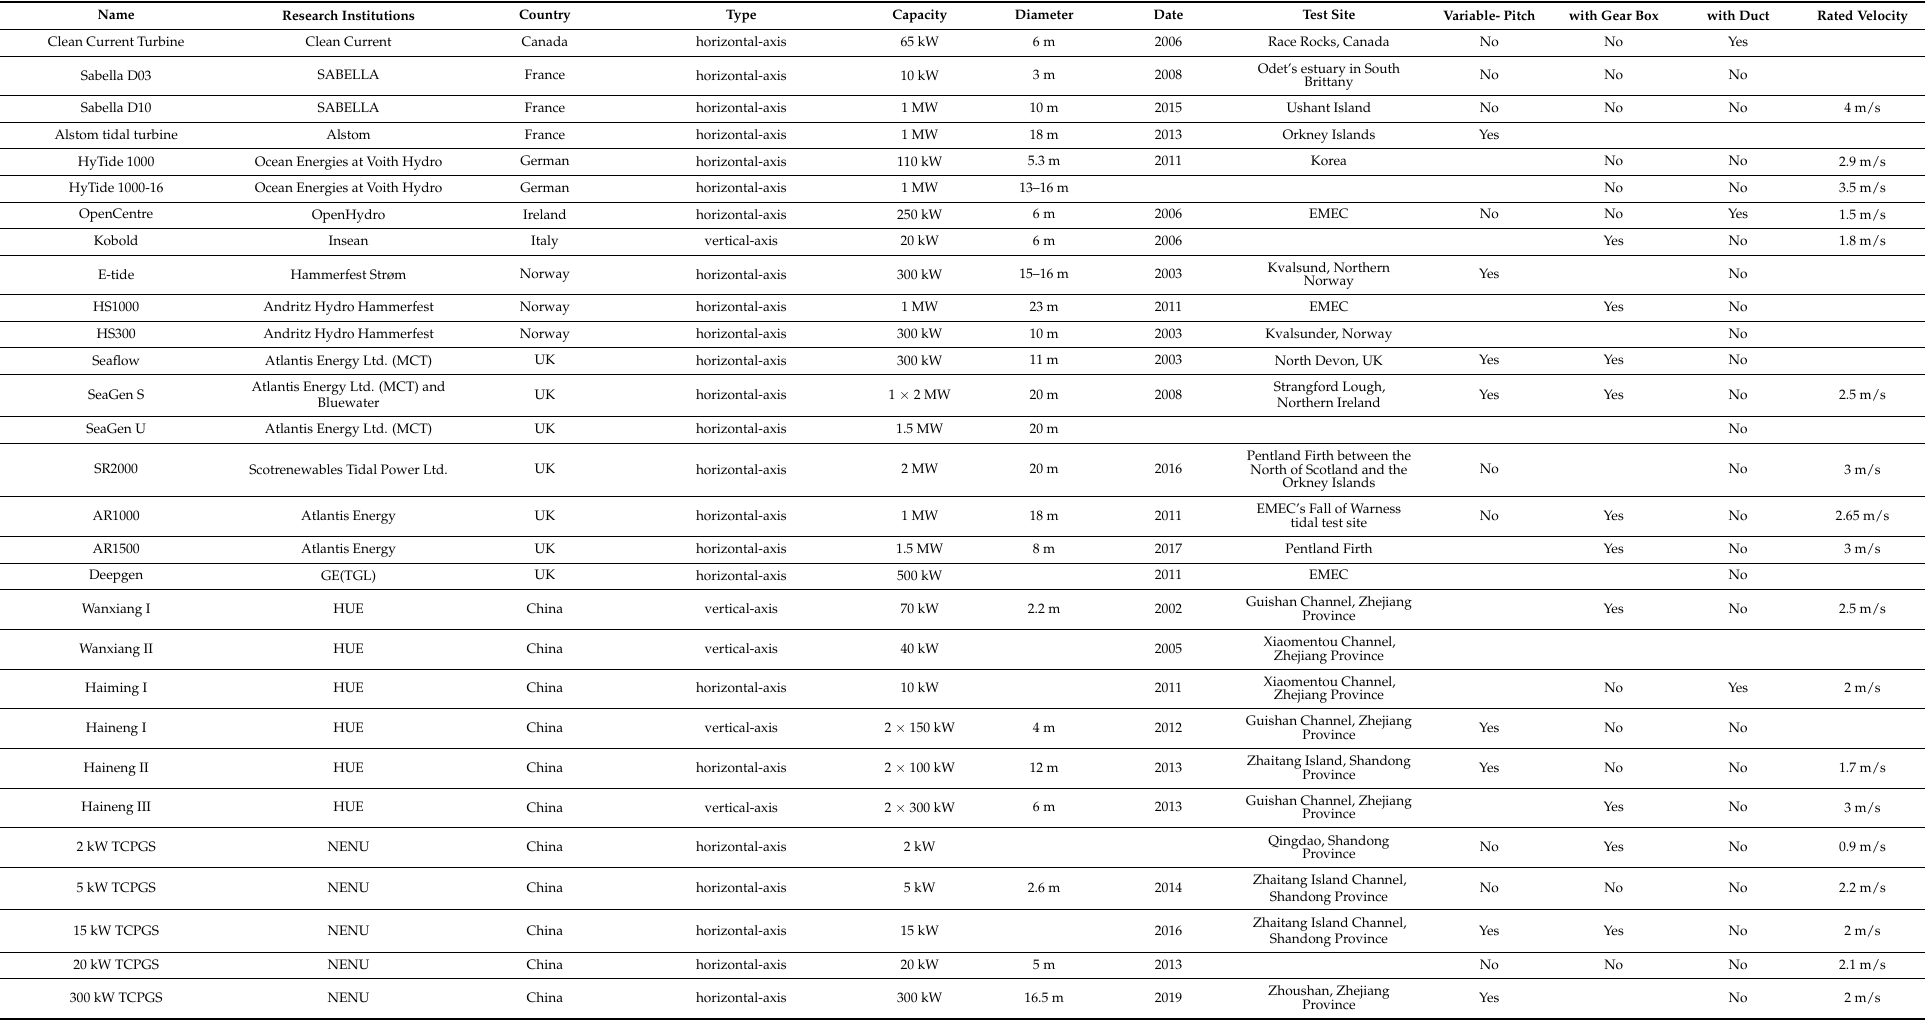
Table 5. Comparison of tidal current power generation technologies between China and other countries